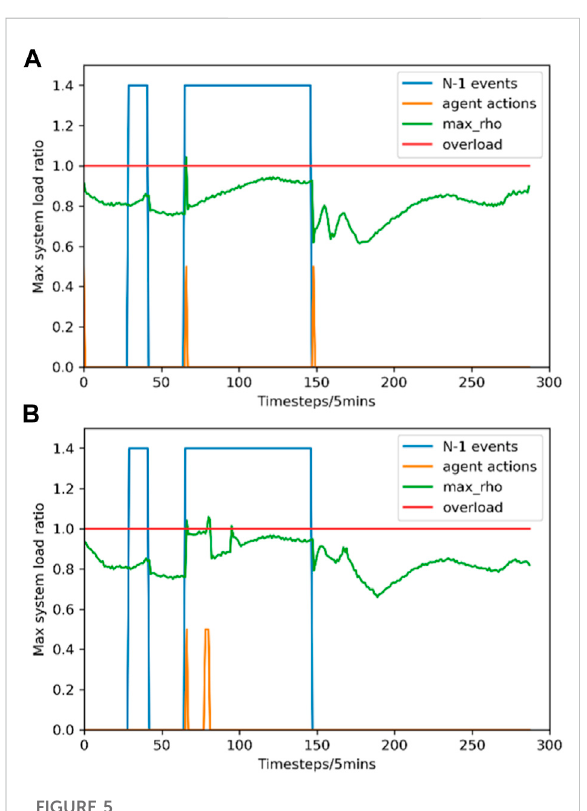
FIGURE 5 System operation status comparison between two methods in Scenario I. (A) Expert policy; (B) PKE-RL method.